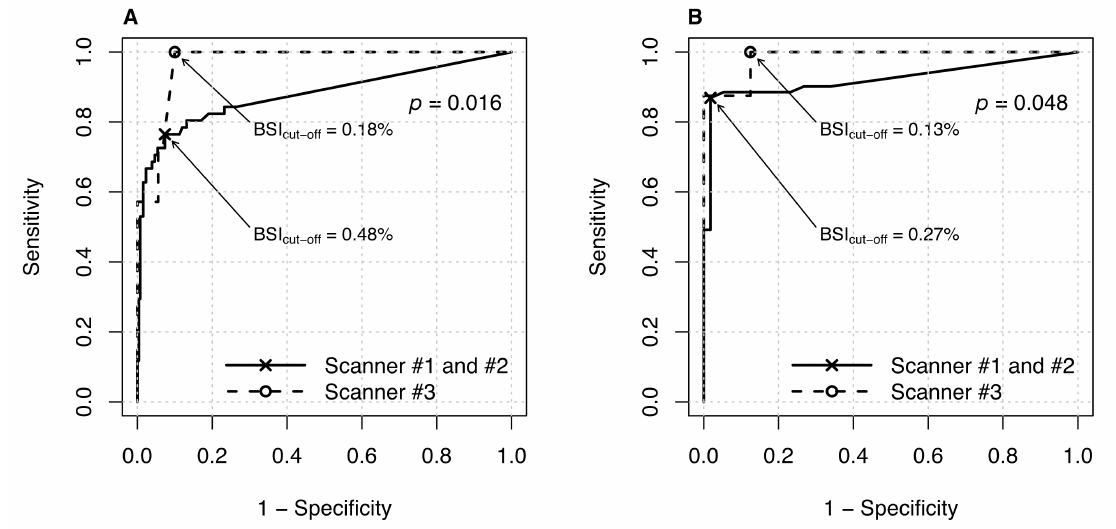
Figure 5. ROC curves for ( A ) breast cancer and ( B ) prostate cancer, illustrating the scanner-specific influence on BSI methodology. The plotted marker (points, stars) reflect the respective best BSI cut-o ff value for each scanner